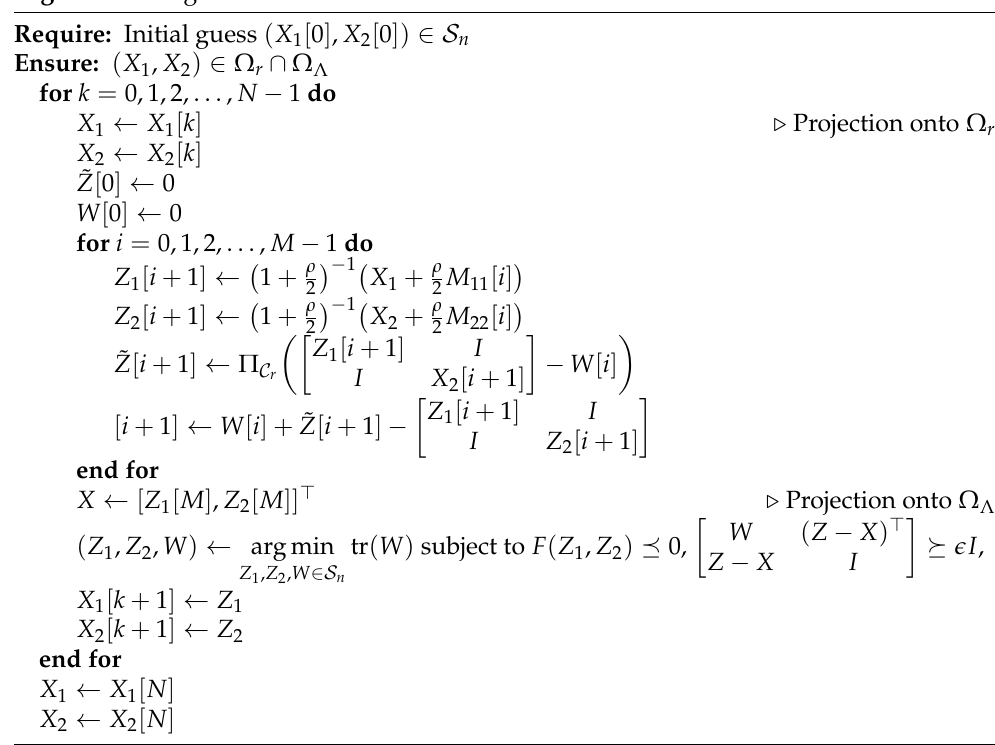
Algorithm 1 Algorithm to solve Problem